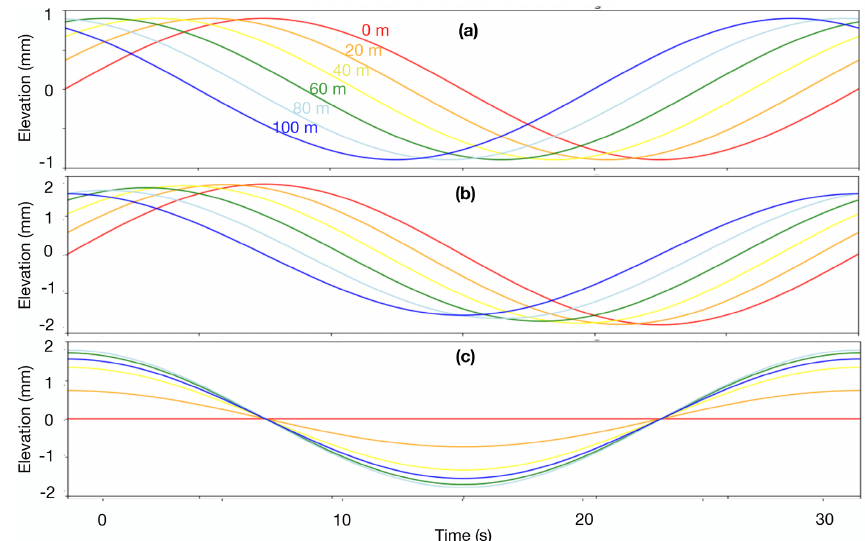
Figure 3. Modeled vertical displacement in the GPRI LOS direction at different positions in range in the following cases. (a) A single wave field with c o = 10ms − 1 , λ = 300m, A = 1mm, and T = 30s. (b) The wave field in panel (a) superimposed on a wave field with the same A and T as in panel (a) but where c o = 20ms − 1 and λ o = 600m. (c) A standing wave expected from an ideal reflection of the wave in panel (a) . Colors represent different locations in range from 0 (red) to 100m